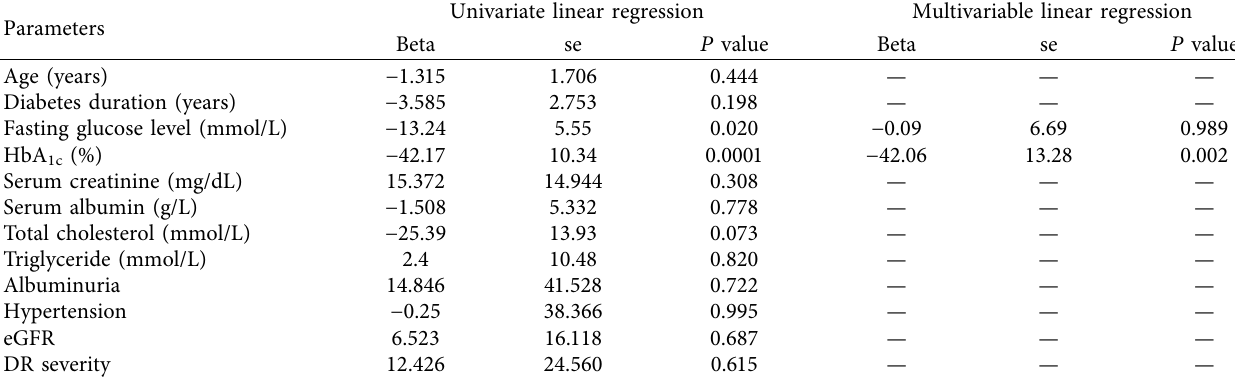
Table 4: Correlating factors for CMT in patients with diabetic macular